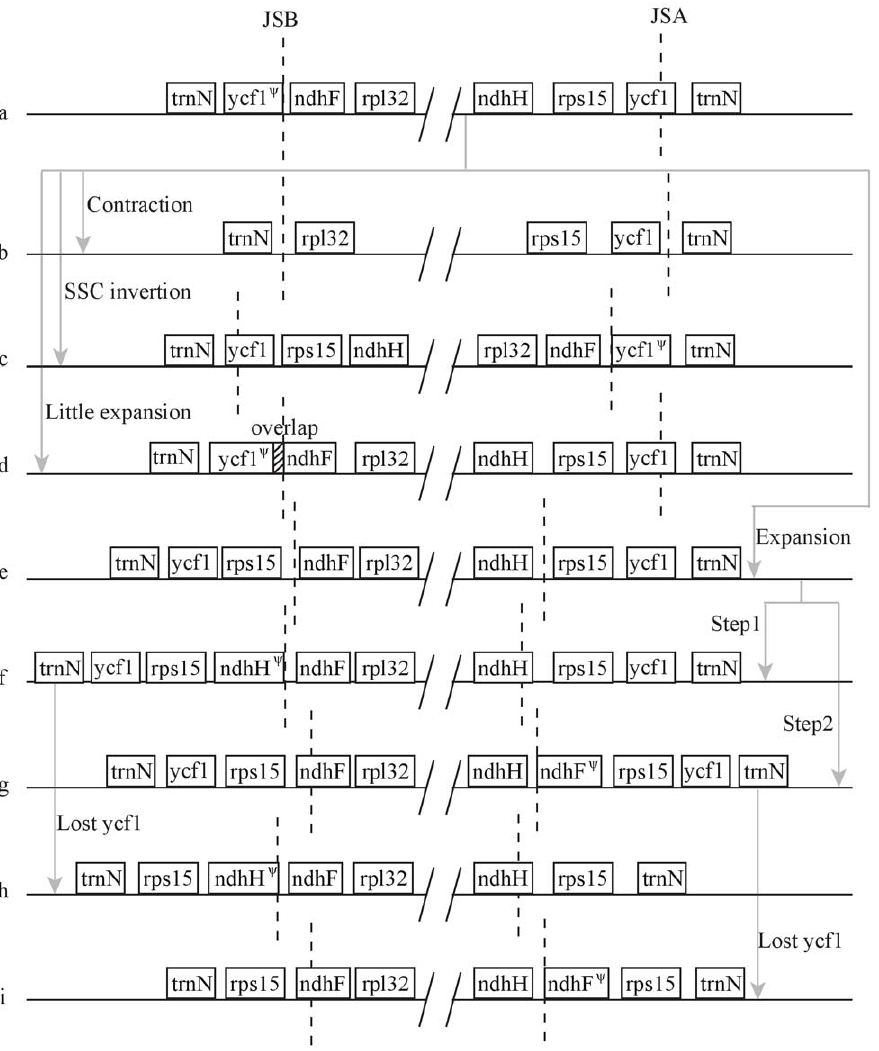
Figure 4. Expansion of IR into the SSC region. The dashed lines depict the junction boundaries. The arrowed grey lines indicate the process of IR expansions. a, Amborella , Nicotiana , typha and two Acoraceae members; b, Phalaenopsis ; c, Dioscorea ; d, date palm and Arabidopsis ; e, intermediate; f, Lemna ; g, intermediate; h, most Poaceaes; i, Panicoideae subfamily including Coix , Maize, Saccharum and Sorghum .